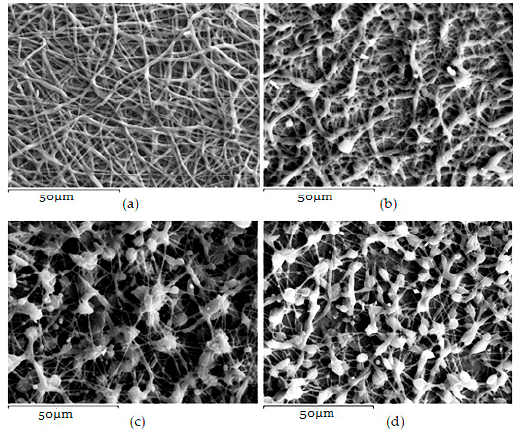
Figure 3. PCL fibers containing: ( a ) 5%; ( b ) 10%; ( c ) 15%; and ( d ) 20 wt % of Voriconazole (VRCZ) drug.